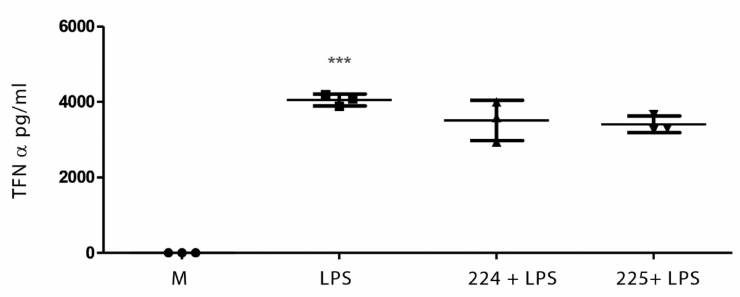
Figure 4. The e ff ect of UK propolis on tumour necrosis factor- α (TNF- α ) production in LPS-stimulated macrophages; n = 3 *** p value < 0.001. Comparisons of LPS against medium and LPS + propolis samples 224 and 225 against LPS.